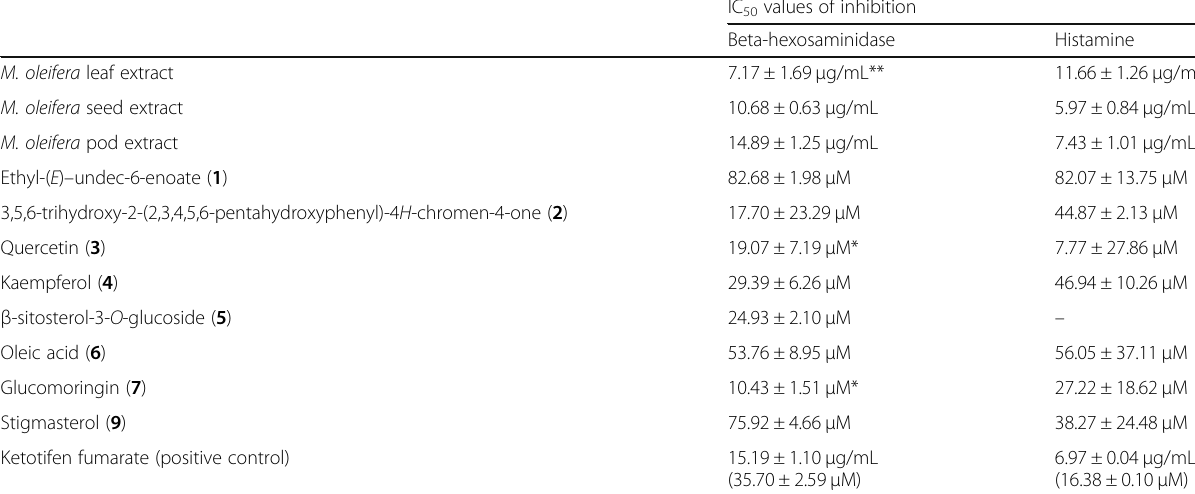
Table 4 IC 50 values of inhibition towards beta-hexosaminidase and histamine